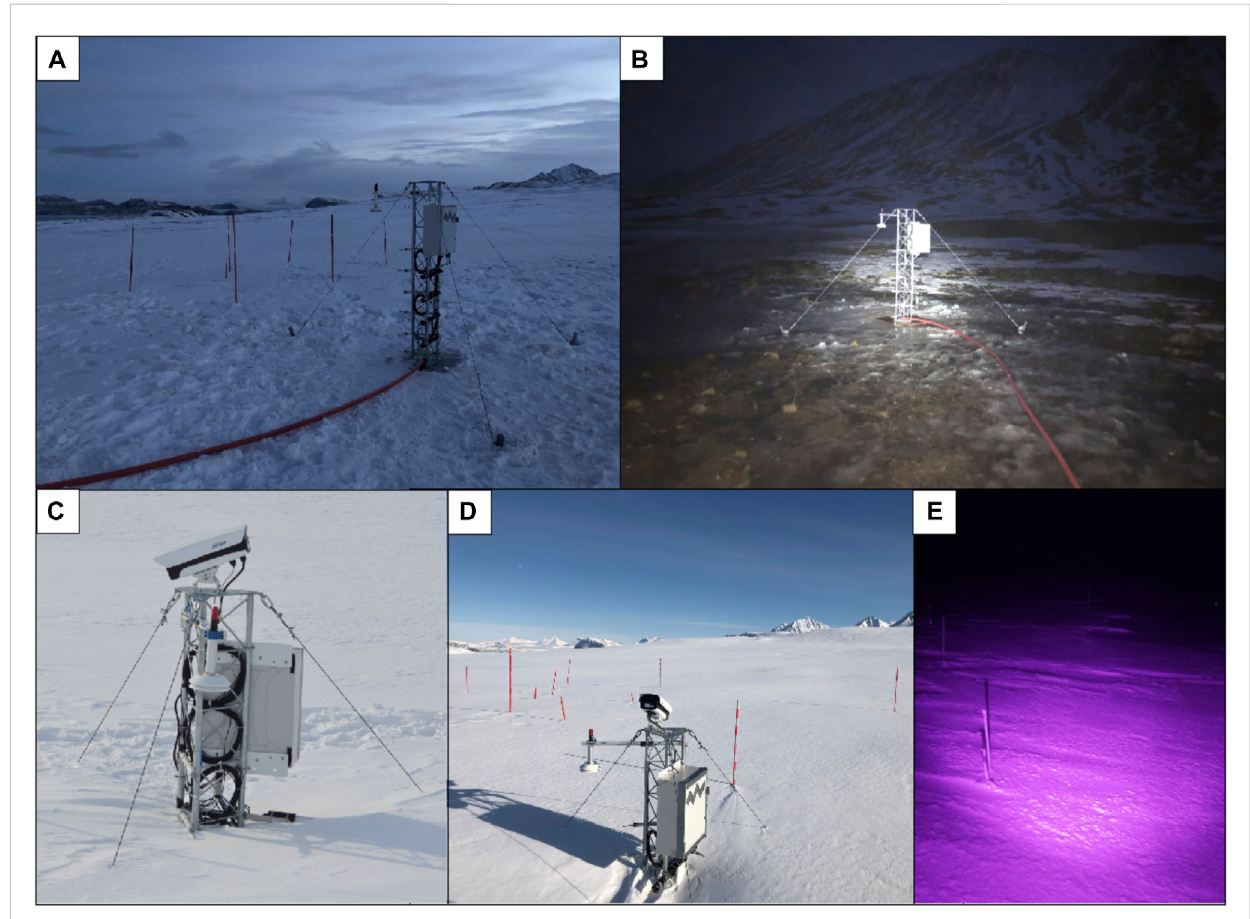
The automated nivometric station (ANS) installed in Gruvebadet (Ny-Ålesund) close to the snow sampling area on (A) November 7th, and (B) 12November2020, afteraROSevent.Notethatthesnowtemperaturesensorswereoriginally installeddirectly ontheANStruss,however,after theROS events we decided to move them to the separate unit to minimise the disturbance of the ANS main structure. (C – D) The NIR camera installed in April 2021 onthetopoftheANStrussand (E) anocturnal imagefromtheNIRcamerainwhich snowtemperaturesensors arevisible. Toassesswhethera given temperature sensor was effectively surrounded by snow during the snow season, snow depth measurements are combined with time-lapse